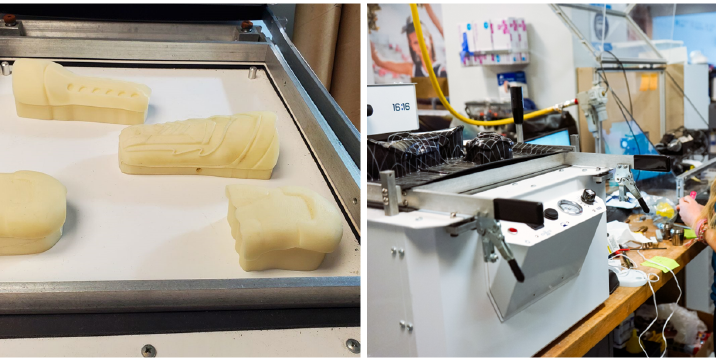
Figure 1. ( Left side ) A converted positive mold or “buck” for thermoforming application. ( Right side ) is thermoformed parts produced from a single sheet of ABS plastic, prepared for